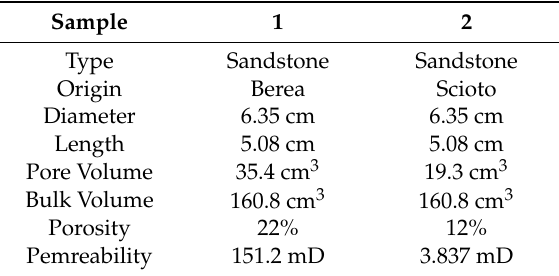
Table 3. Core Sample Characterization.